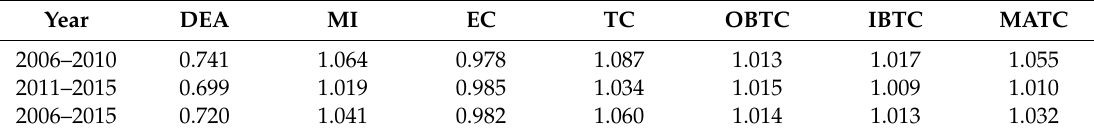
Table 4. Data envelopment analysis (DEA), Malmquist index (MI) and the decomposition